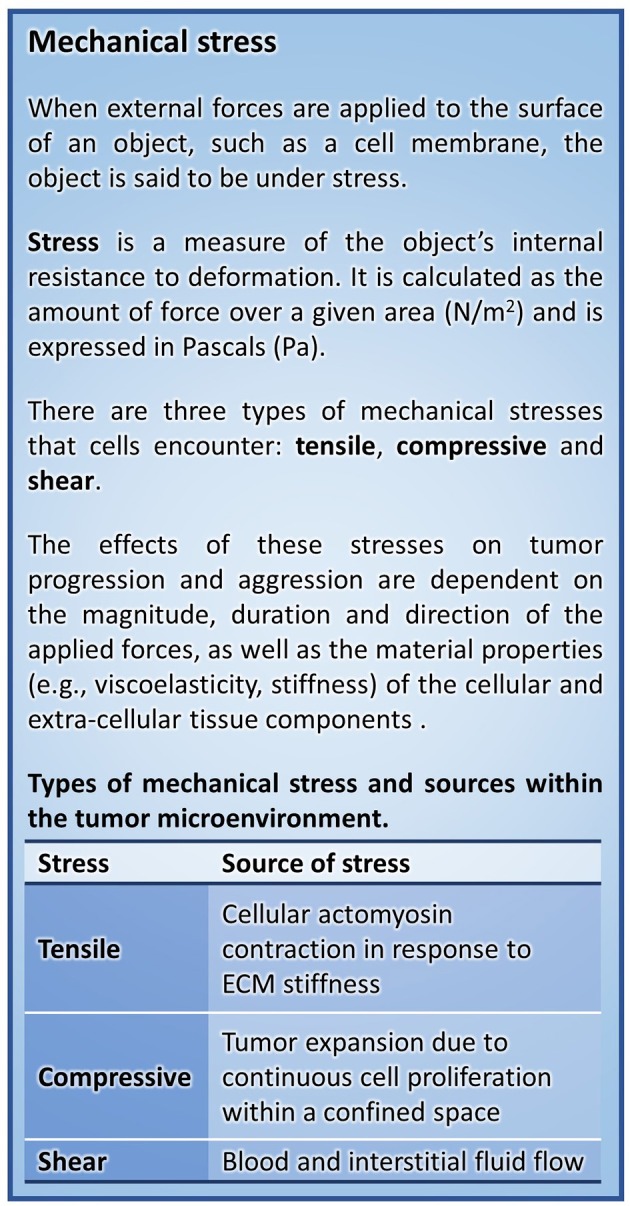
Mechanical stress.